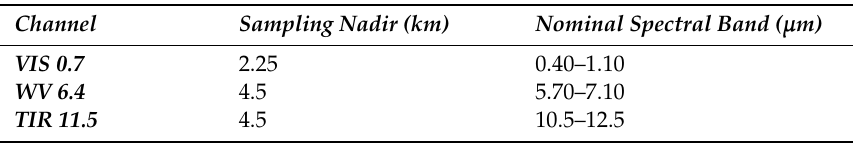
Table 1. Spatial and spectral characteristics of Meteosat Visible Infra-Red Imager (MVIRI) visible (VIS), thermal infrared (TIR) and water vapour (WV)